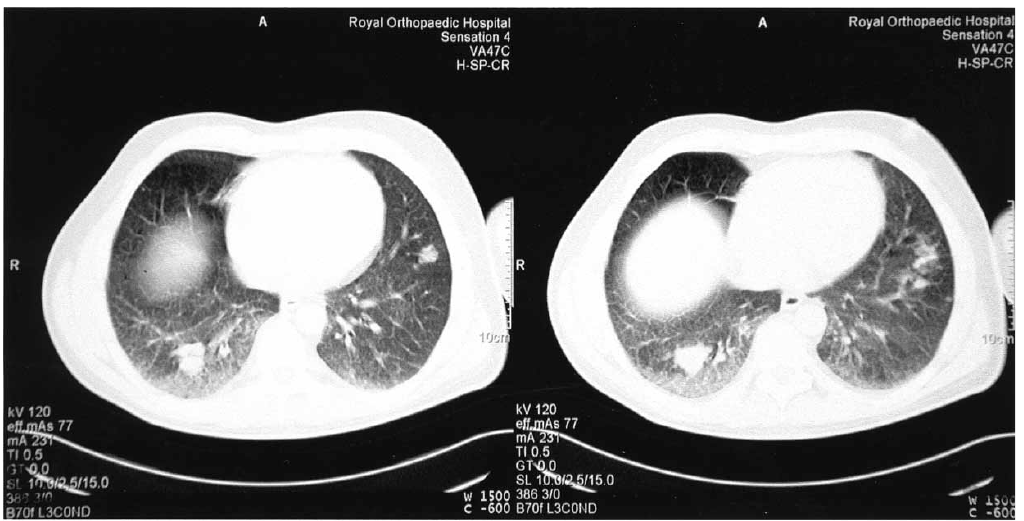
Figure 4. Computed tomography of the chest. This shows lung window images of the bases showing irregular nodular lesions measuring up to 2cm in diameter, suggestive of pulmonary metastases. Chondrosarcoma usually produces macro nodular